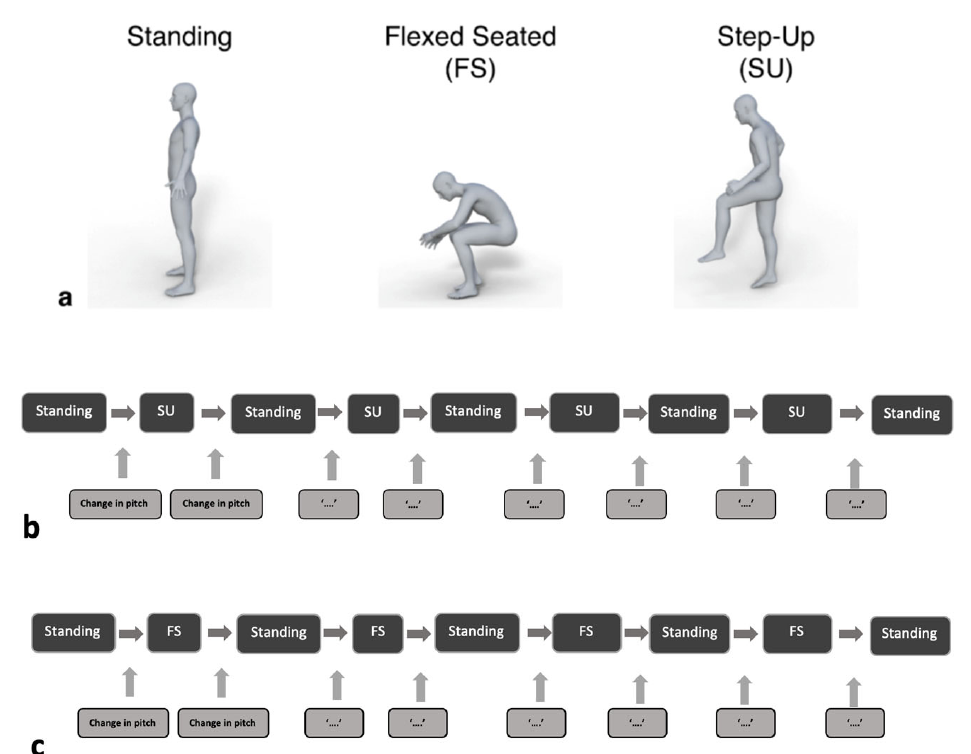
Figure 2. ( a ) The different positions assumed by patients during the procedure: standing, flexed-seated (FS) and step-up (SU). ( b , c ) Repeated measures were then taken in both FS and SU positions with return to standing position in between each measurement. Patients were asked to maintain each position for a minimum of five seconds, during which the IMU data and radiograph image were captured.